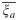
The mean active fraction of receptors ξa¯ plotted against R0 for three different A0 and fixed ℓ = 20.Inset: The corresponding variances.